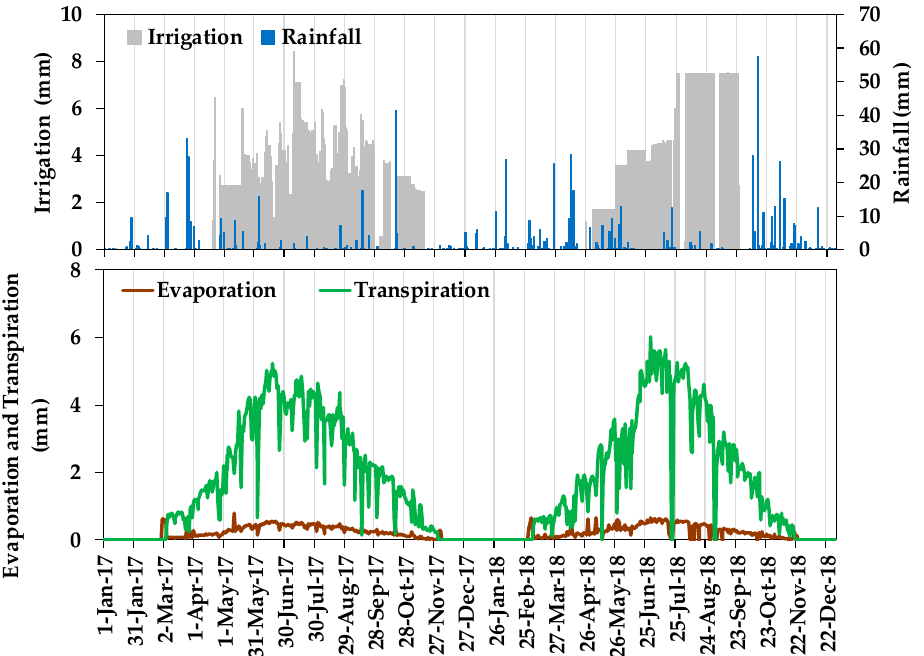
Figure 1. Irrigation, rainfall, evaporation and transpiration during the years 2017 and 2018.